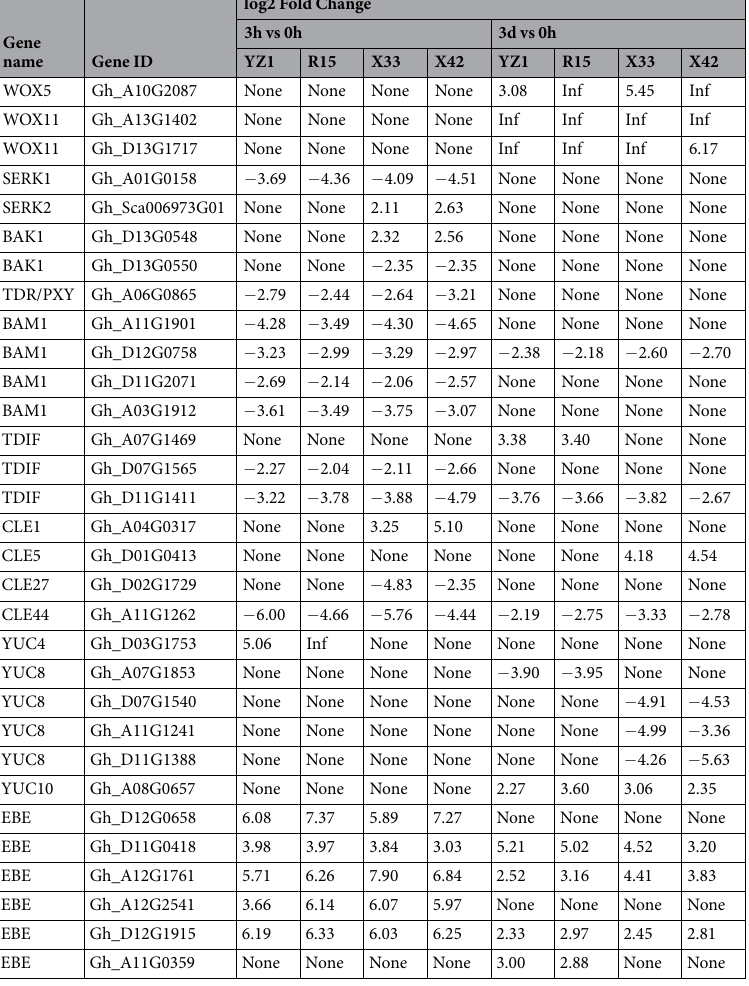
Table 3. The log2 fold change of SE-related genes in different-stage comparisons. (Note: Among the 3d vs 0h, Inf indicates that the FPKM of WOX5 was close to 0 at